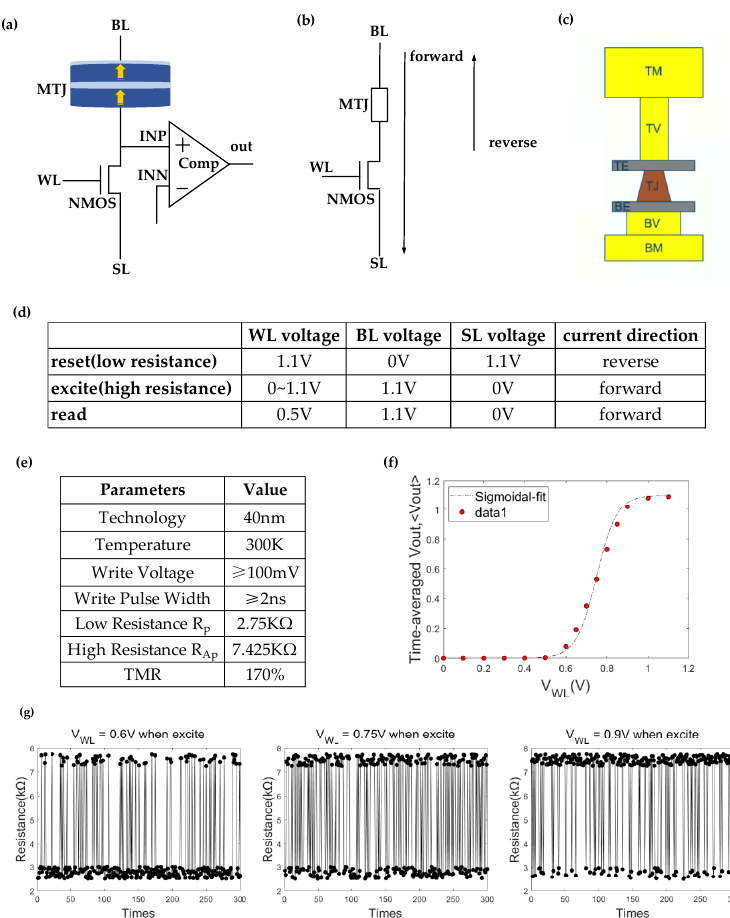
Figure 2. ( a ) Schematic diagram of the E-spin. ( b ) Operation paradigm of the E-spin. ( c ) The layout of the MTJ ’ s film stack. The technology node of our logic circuit was 40 nm. The MTJ was fabricated on the top layer of the logic circuit. ( d ) The applied voltage for the reset, excite, and read operations. ( e ) The parameters of MTJ were measured at 300 K. The low resistance was 2.75 KΩ and the high resistance was 7.425 KΩ . The TMR (Tunnel Magneto Resistance) was 170%. The switch error rate of the MTJ was correlated with the write voltage and pulse width. The minimum write voltage and pulse width were 100 mV and 2 ns, respectively. ( f ) Time-averaged 𝑉 𝑜𝑢𝑡 , < 𝑉 𝑜𝑢𝑡 >. < 𝑉 𝑜𝑢𝑡 > is the function of the applied input voltage 𝑉 𝑊𝐿 and pulse width. The pulse width is 5 ns in this illustration. The function is fitted to the sigmoidal function. Each data point shown in this figure was averaged for 300 sampling points. ( g ) Time snapshots of the MTJ ’ s resistance after each excite operation for various input voltage 𝑉 𝑊𝐿 (0.6 V, 0.75 V, and 0.9 V). The MTJ ’ s resistance was sampled 300 times for each 𝑉 𝑊𝐿 .